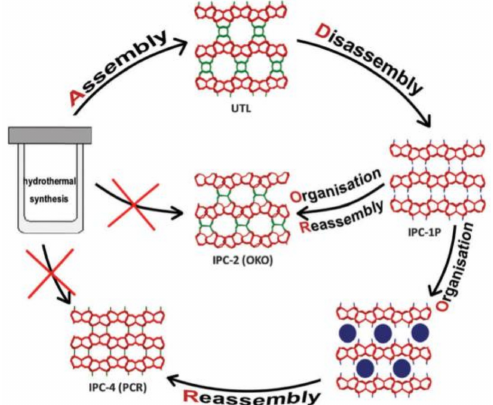
Figure 18. The ADOR method in a cycle scheme demonstrating the mechanism for the synthesis of two novel zeolites, IPC-2 (OKO) and IPC-4 (PCR), in which of them have not been sofa prepared by direct hydrothermal synthesis. The interlay bonds are highlighted in green, and the terminal silanol groups in blue. Reprinted with permission from ref. [8]. Copyright 2015, Royal Society of